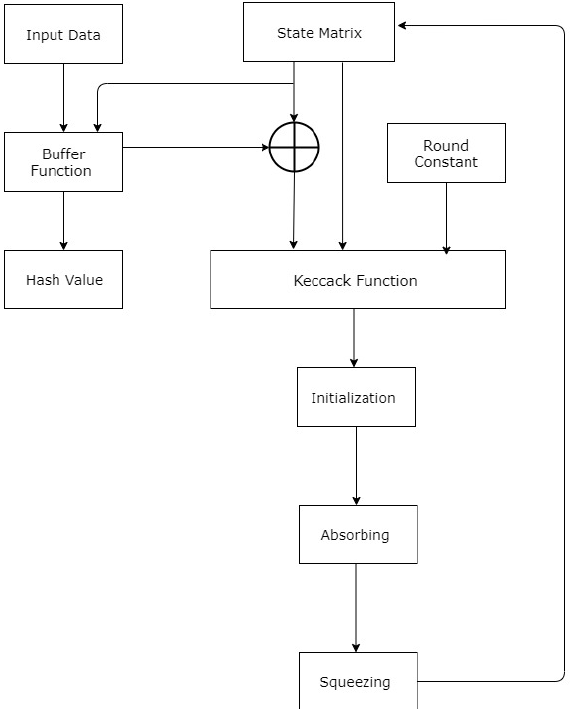
Figure 1. Block diagram of Keccak algorithm.